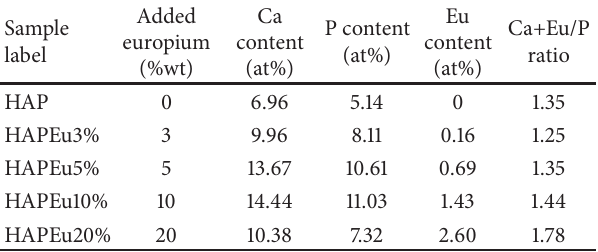
Table 1: EDS results of the samples prepared in this work.